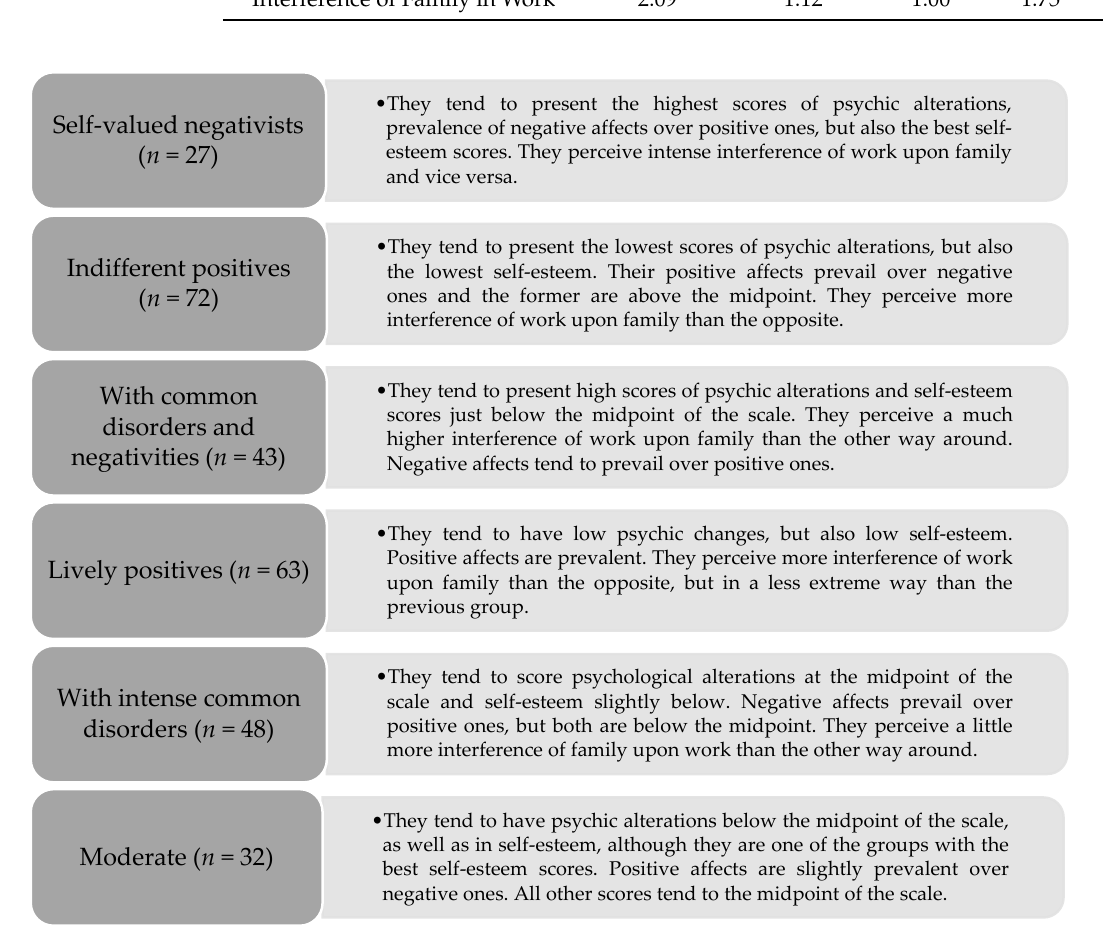
Figure 2. Profiles of mental health.